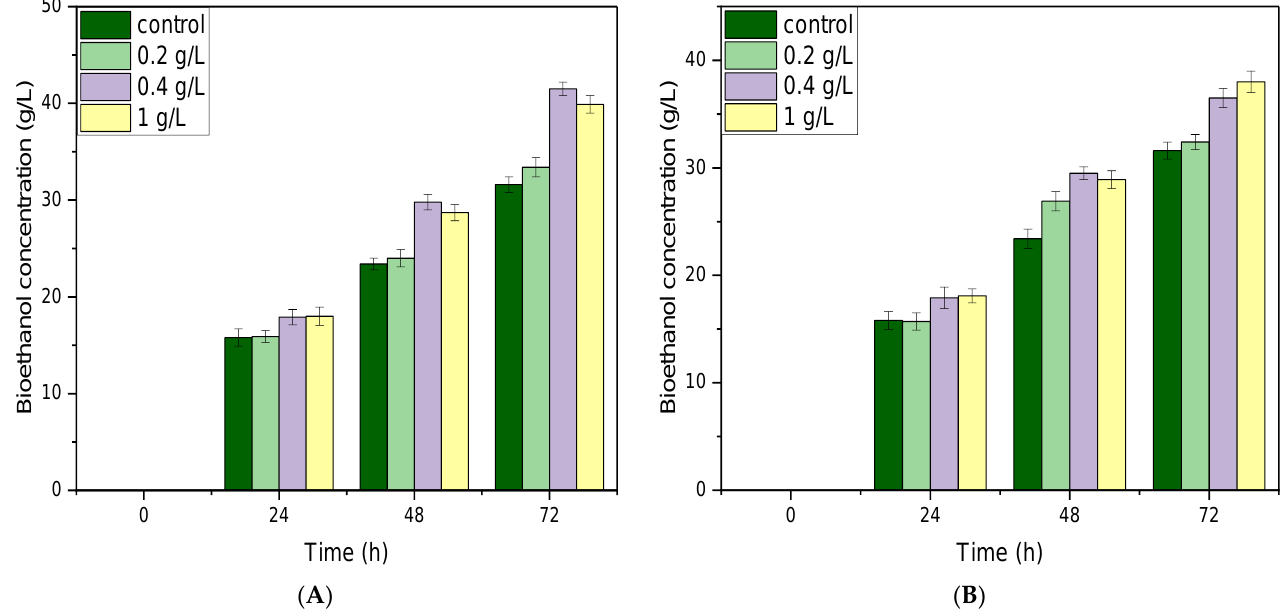
Figure 1. Bioethanol concentration during alcoholic fermentation: ( A ) effect of CaCl 2 and ( B ) effect of CaCO 3 .